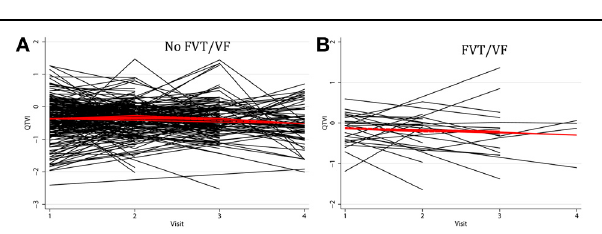
FIGURE 6 | “Spaghetti” plots of individual patient-specific longitudinal relationships between QTVI NF and time for each subject with (A) presenting ventricular-sensed (VS), and (B) presenting ventricular-paced (VP) sinus rhythm.